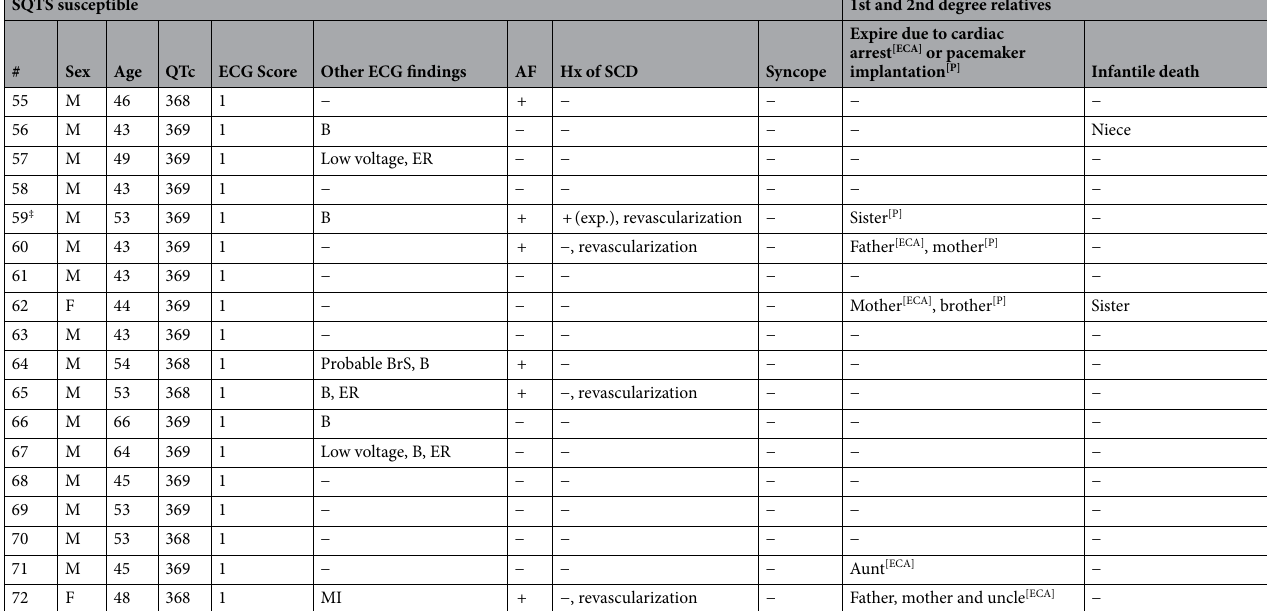
Table 3. Detailed data of subjects with QTc of lower than 370 ms at the baseline ECG. M male, F Female, B bradycardia, BrS Brugada syndrome, ER early repolarization, LBBB left bundle branch block, LVH left ventricular hypertrophy, exp. expired, Sx syndrome, MI myocardial infarction, P palpitation, SCD sudden cardiac death, Hx history, ECG electrocardiogram, CABG coronary artery bypass graft, [ECA] (expired due